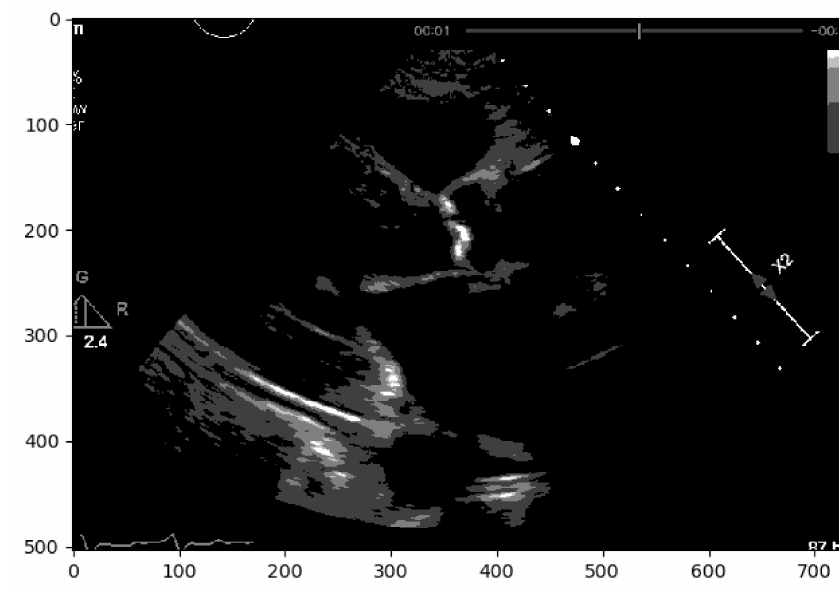
Figure 2. Echocardiography image with region-based segmentation.